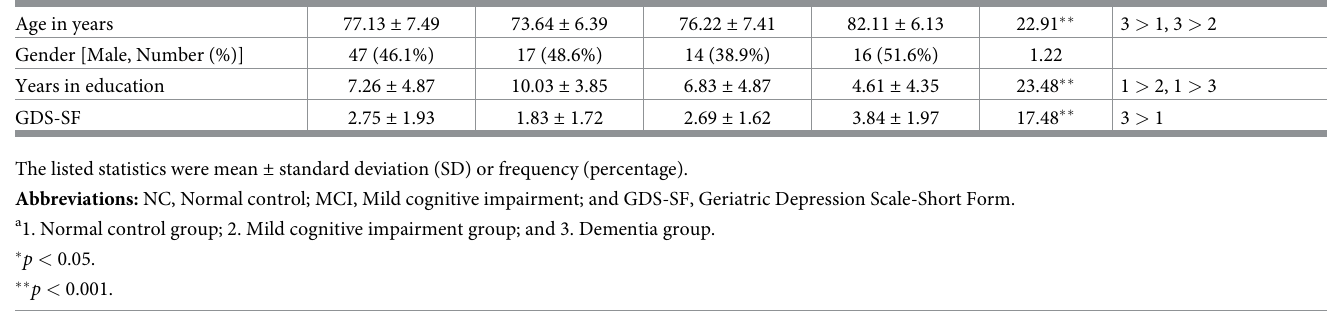
Table 1. The demographic characteristics of the participants stratified by NC, MCI and dementia.